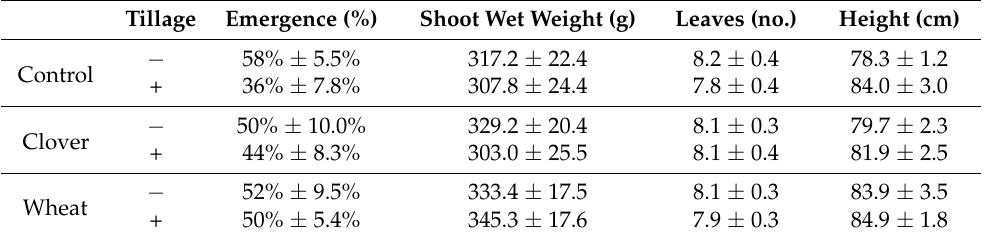
Table 5. The 2020 commercial fields soil experiment—growth parameters at 43 DAS 1 .